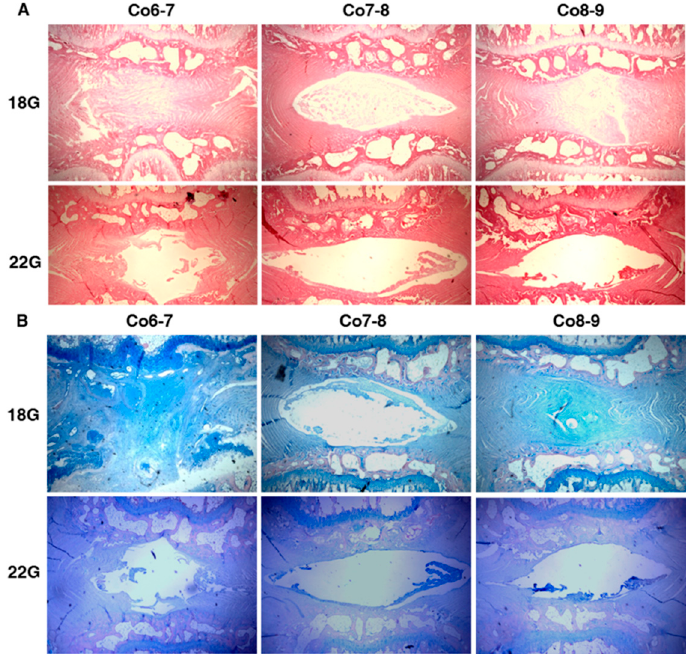
Figure 1. ( A ) Hematoxylin and eosin stain and ( B ) Alcian blue stain for comparing the morphological and proteoglycan changes of control and punctured discs with 18-guage and 22-guage needles (original magnification: 40×). The control disc, Co7-8, showed a rounded nucleus pulposus and a well-organized annulus fibrosus with a well-defined border. The punctured discs, Co6-7 and Co8-9, showed a clustered NP and a disordered AF with an interrupted border.